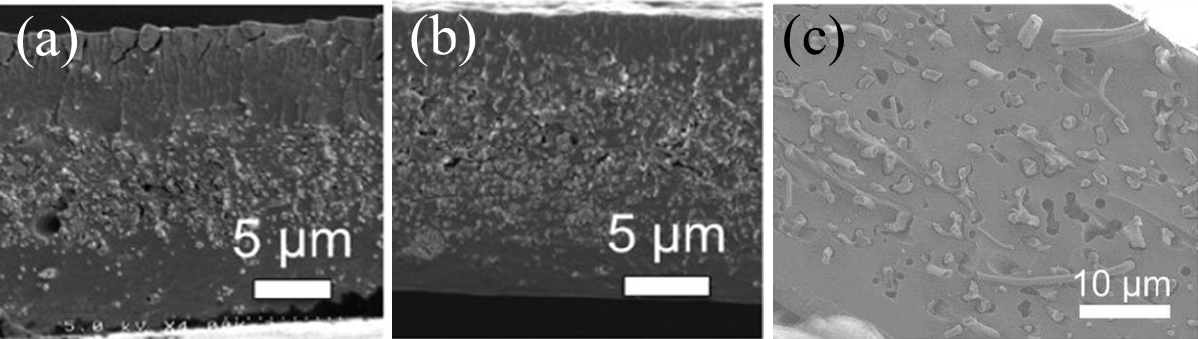
Figure 4. Freeze-fractured cross-section SEM images of nanofiber composite membranes; ( a ) a tri-layer 825 EW PFSA (matrix)/PAI (fiber) composite membrane with 80 wt.% PFSA with a low PAI nanofiber content in the outer layers and a higher PAI fiber content in the inner layer. Reproduced with permission from Ref. [55]. ( b ) An 825 EW PFSA (matrix)/PAI (fiber) composite membrane with 80 wt.% PFSA where the PAI fiber content is continuously and symmetrically changing from the membrane centerline (high PAI fiber content) to the membrane surfaces (low PAI content). Reproduced with permission from Ref. [55]. ( c ) Pore-filled cPPSA (matrix)/PPSU (fiber) composite membrane with 75 wt.% cPPSA. Reproduced with permission from Ref. [62].